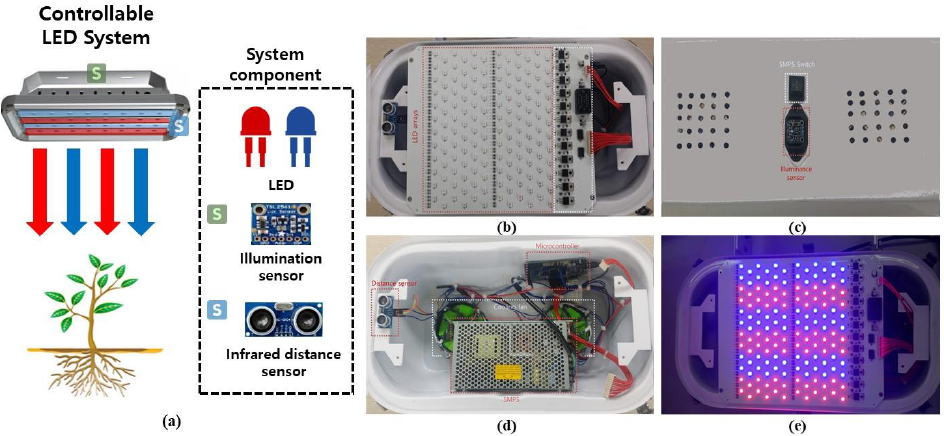
Figure 5. Implemented prototype of the proposed system: ( a ) overall system; ( b ) front side; ( c ) back side; ( d ) functional modules; and ( e ) system operation.